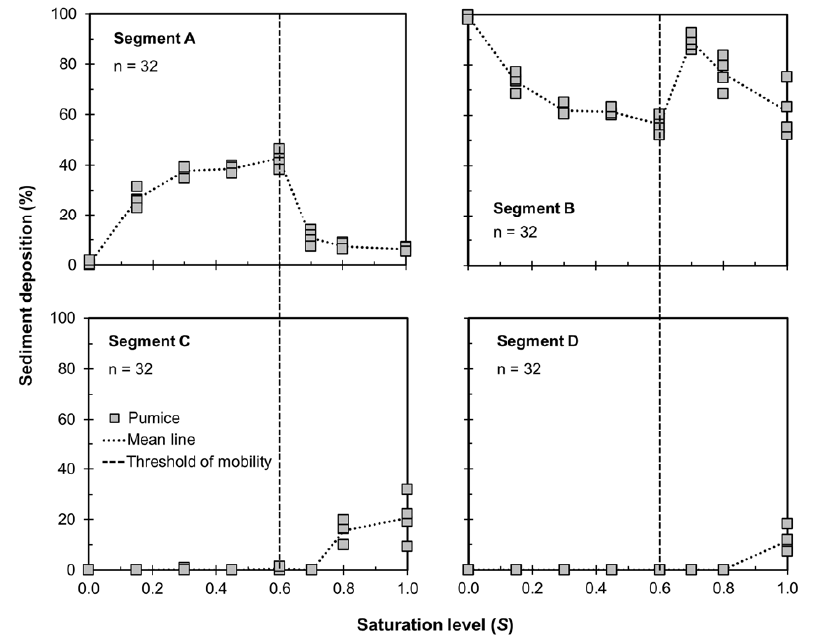
Figure 5. Sediment deposition in all flume segments. X-axis shows saturation levels, where S = 0 represents completely dry conditions and S = 1 represents completely saturated conditions. Y-axis shows the percentage of sediment deposition in all flume segments (%). Segments A, B, C, and D represent the initiation, upper deposition, lower deposition, and outlet segments, respectively.